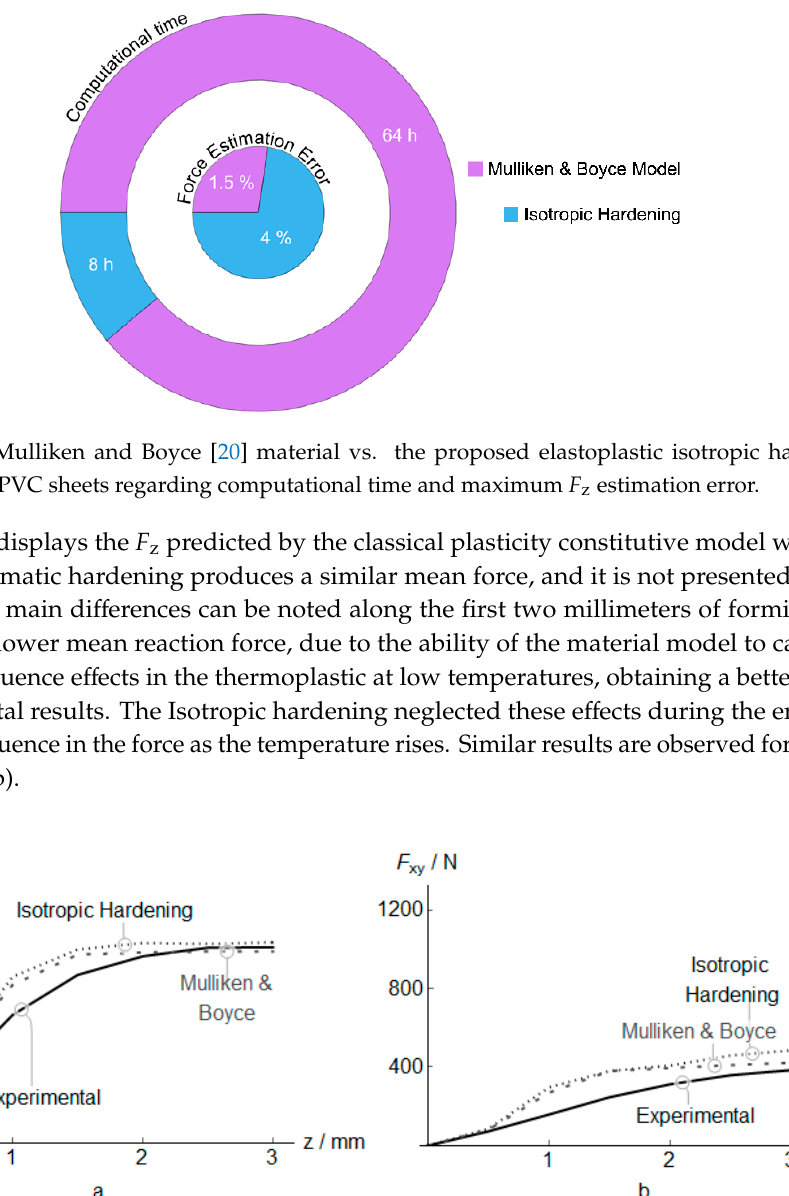
Figure 12. Mean force during PVC incremental forming at z positions. Vertical force ( a ), and in-plane force ( b ).